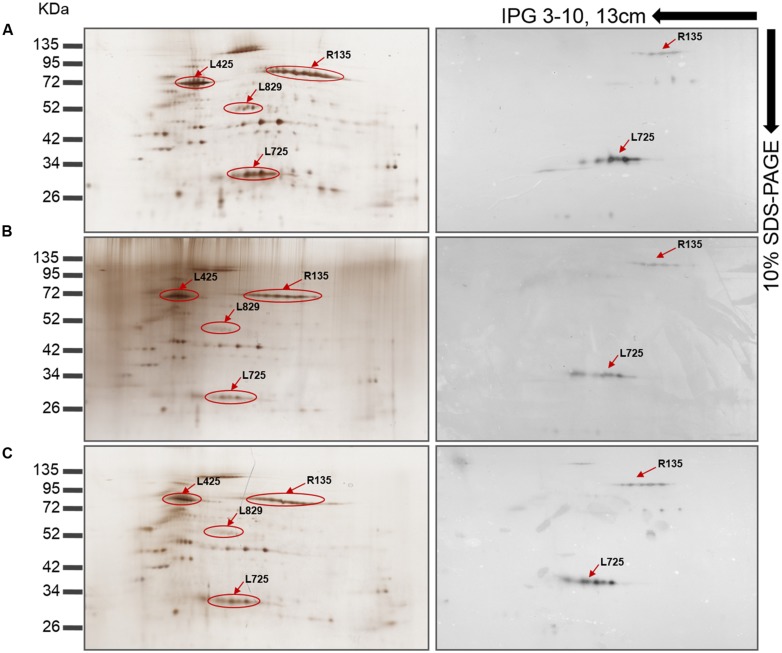
Mimivirus protein profiles as shown by 2D-gel electrophoresis and western blot with anti-fiber antibodies (1:5000). (A) Silver stained and western blotted gel electrophoresis of Mimivirus in the absence of siRNA. (B) Silver stained and western blotted gel electrophoresis of si-L829 Mimivirus. (C) Silver stained and western blotted gel electrophoresis of si-R856 Mimivirus. The decrease in spot intensity indicates the depletion of fiber proteins. Immunoreactive protein spots are shown using arrows and the locus names; the spots were previously identified in (Renesto et al., 2006; Boyer et al., 2011).